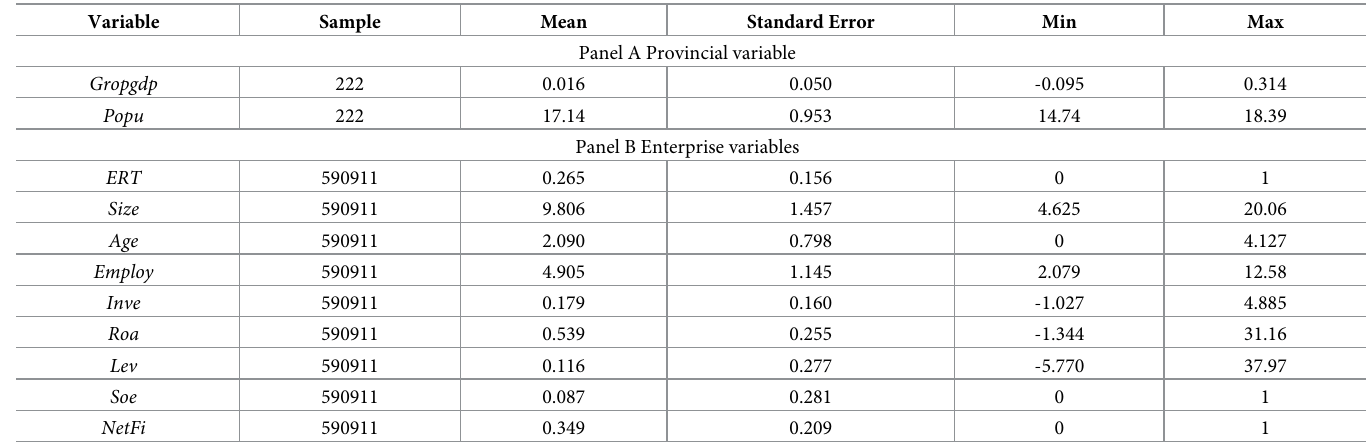
Table 1. Descriptive statistics of the core